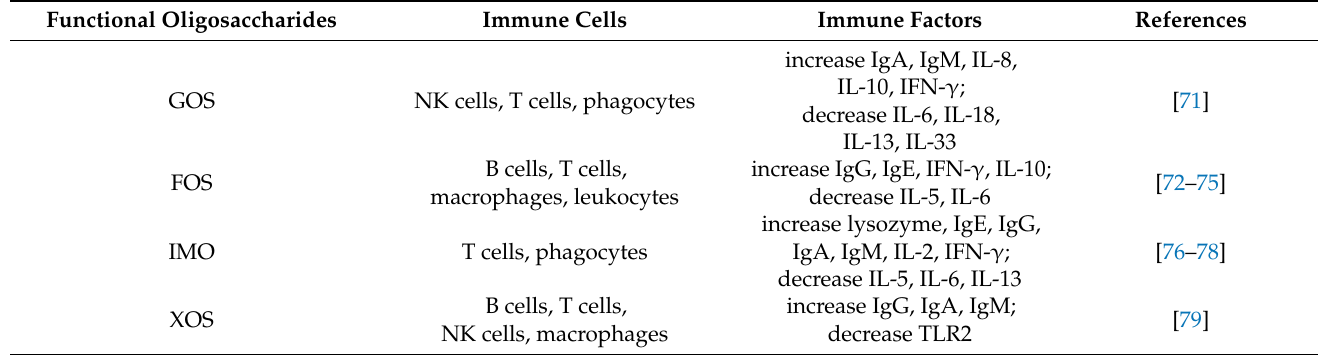
Table 3. The mode of action of common functional oligosaccharides on the intestinal immune barrier. Functional